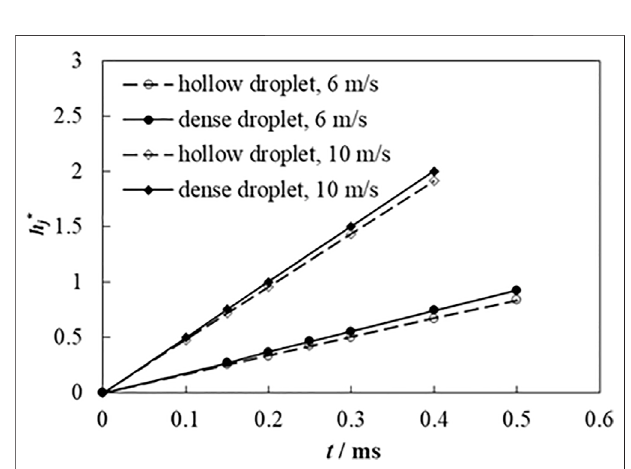
FIGURE 8 | Central jet height of droplets at impact velocities of 6 and 10 m s − 1 .